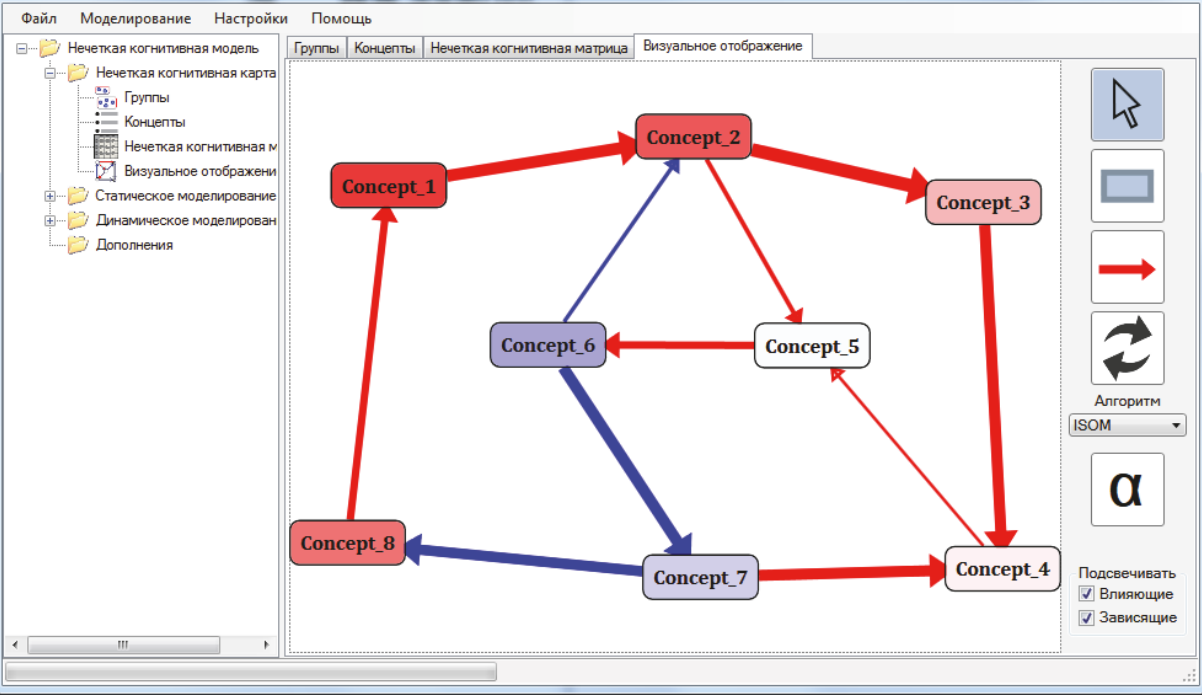
Fig. 3. Example of a fuzzy cognitive